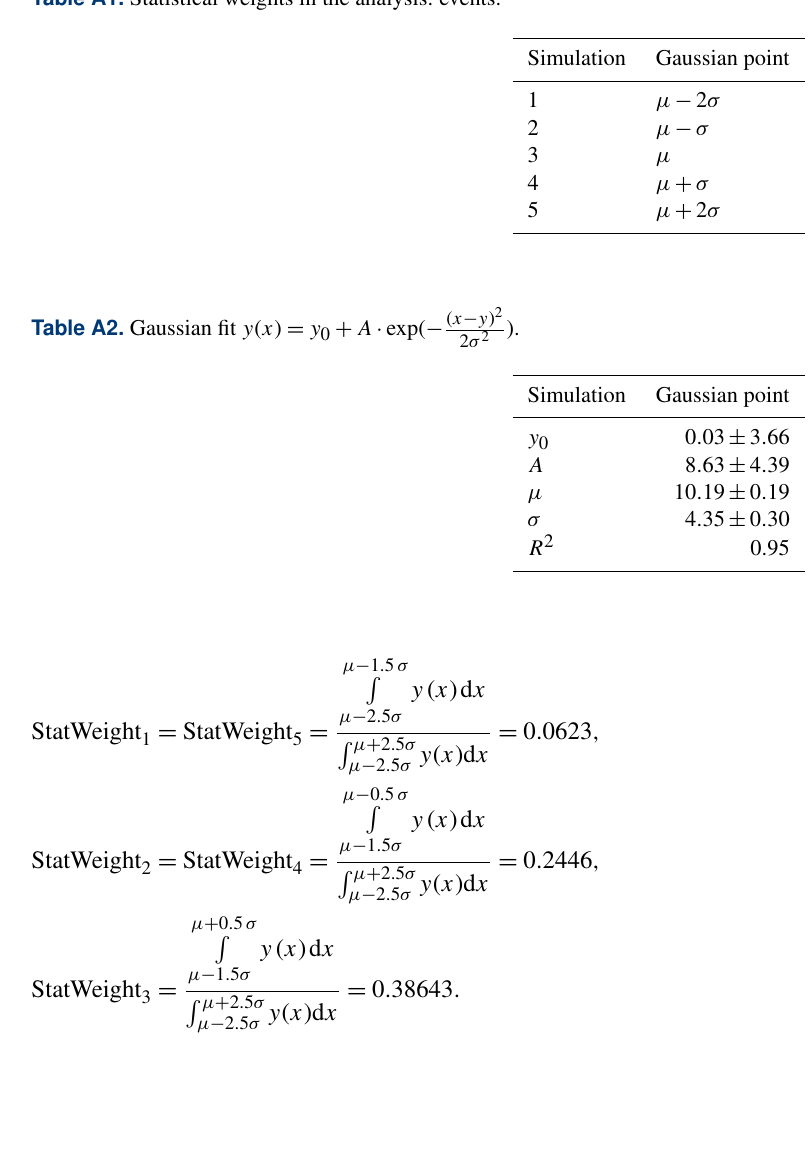
Table A1. Statistical weights in the analysis: events.